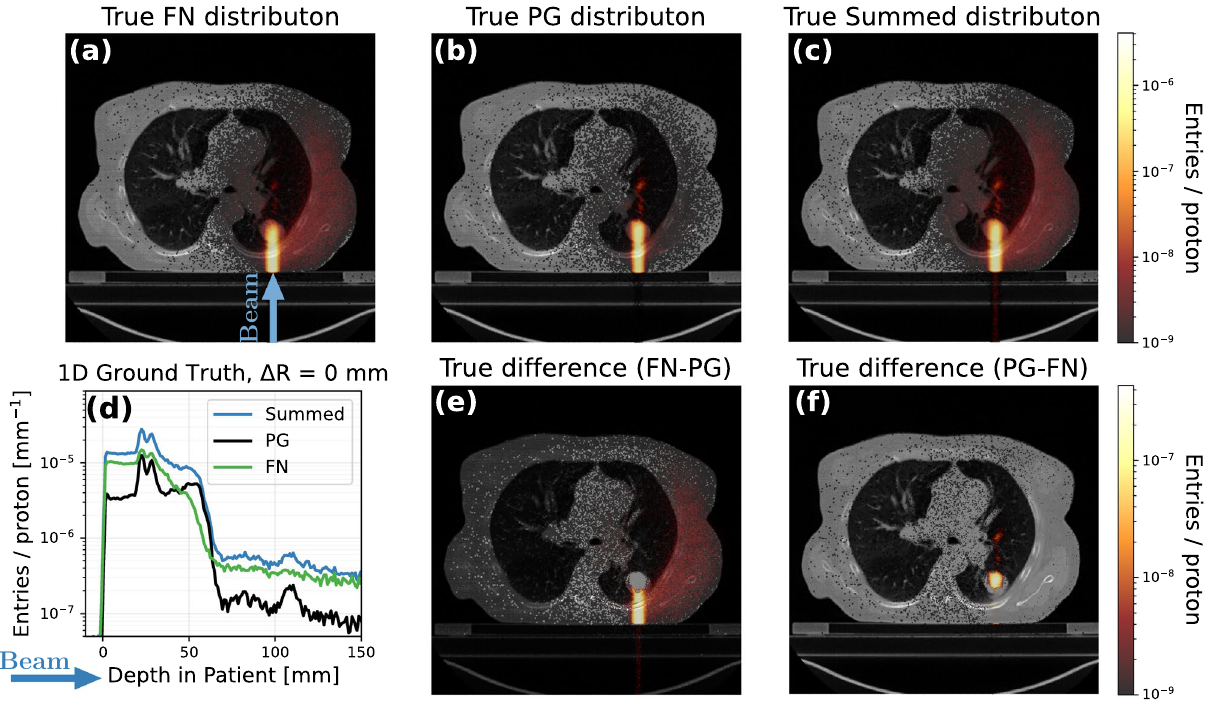
Figure 2. 2D and 1D ground truth distributions of detected FNs and PGs. ( a , b ) 2D ground truth distributions of successfully detected FNs and PGs obtained for the laterally positioned NOVCoDA ( θ = 90 ◦ ). Also shown are the combined distributions ( c ), the difference between FN and PG distributions ( e ), the difference between PG and FN distributions ( f ) as well as a 1D projection of the production distributions of detected FNs and PGs along the incident proton beam axis ( d ). Clearly, both the 1D and 2D the distributions indicate that FNs predominate the overall response at shallower depths whereas PGs predominate near the end of range of the incident proton